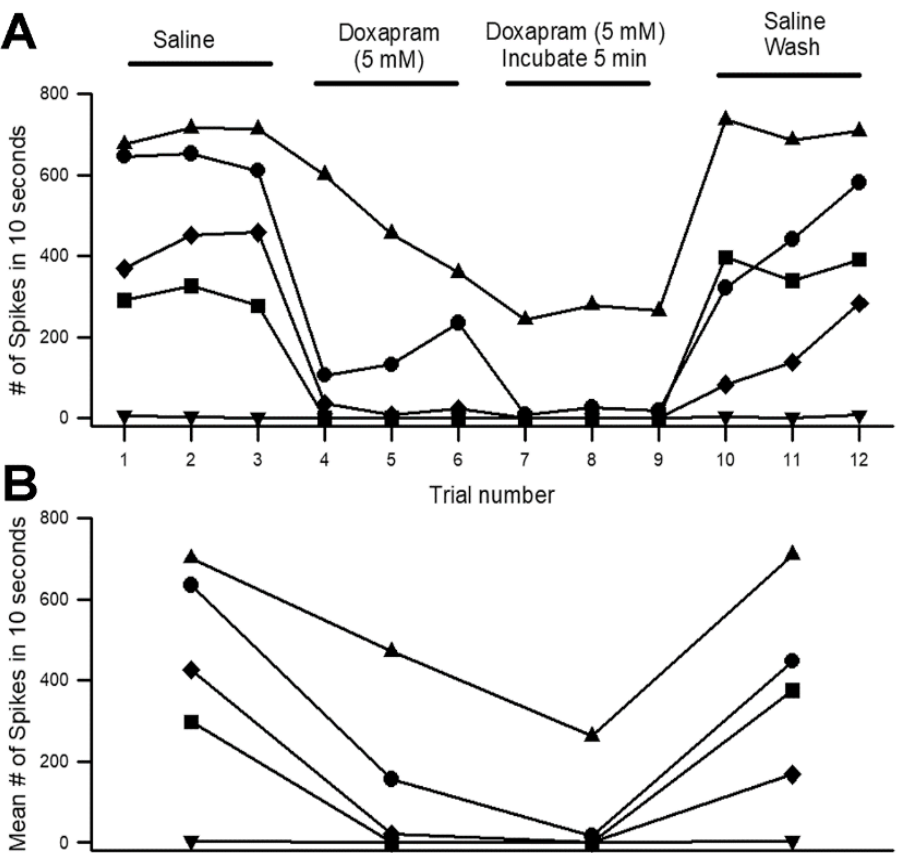
Figure A1. The activity obtained from the PD nerve for five different groups within a university course for the effect of doxapram (5 mM). ( A ) The number of spikes were measured in the same way and by the same person who measured all the traces independently of the student participants for consistency in analysis. ( B ) The number of spikes in each of the three trials was averaged and graphed in the same manner as in ( A ), which allows an easier view of the overall effects.